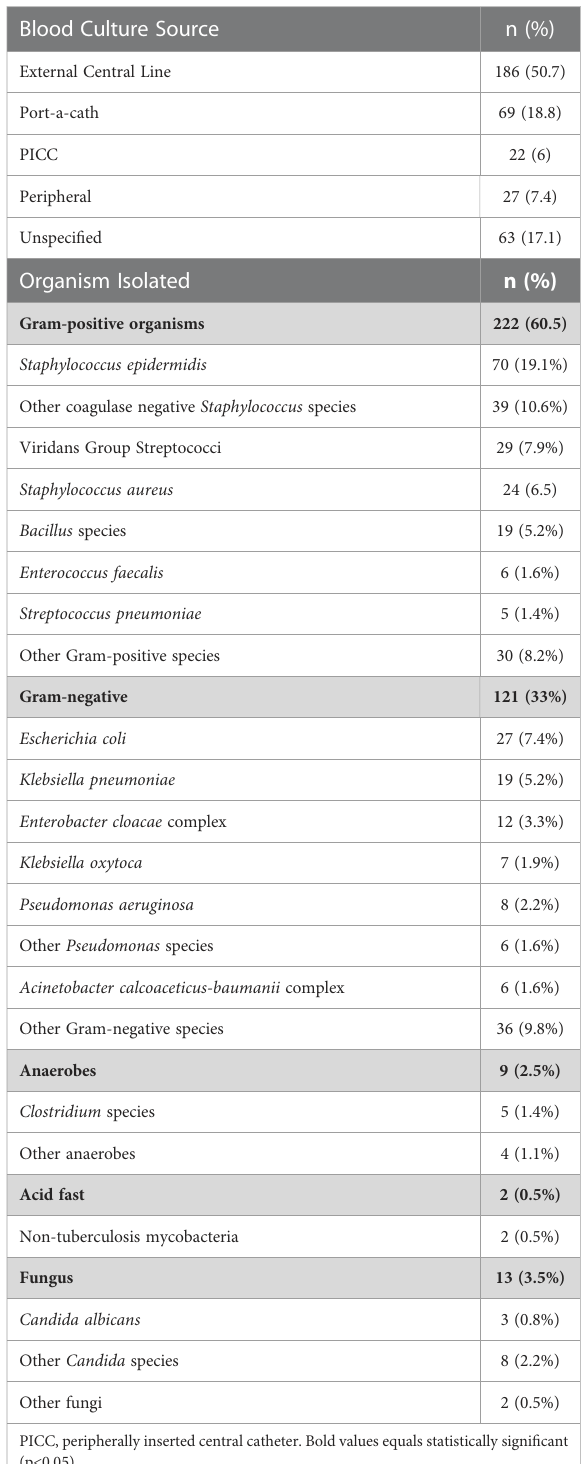
TABLE 2 Characteristics of positive blood cultures